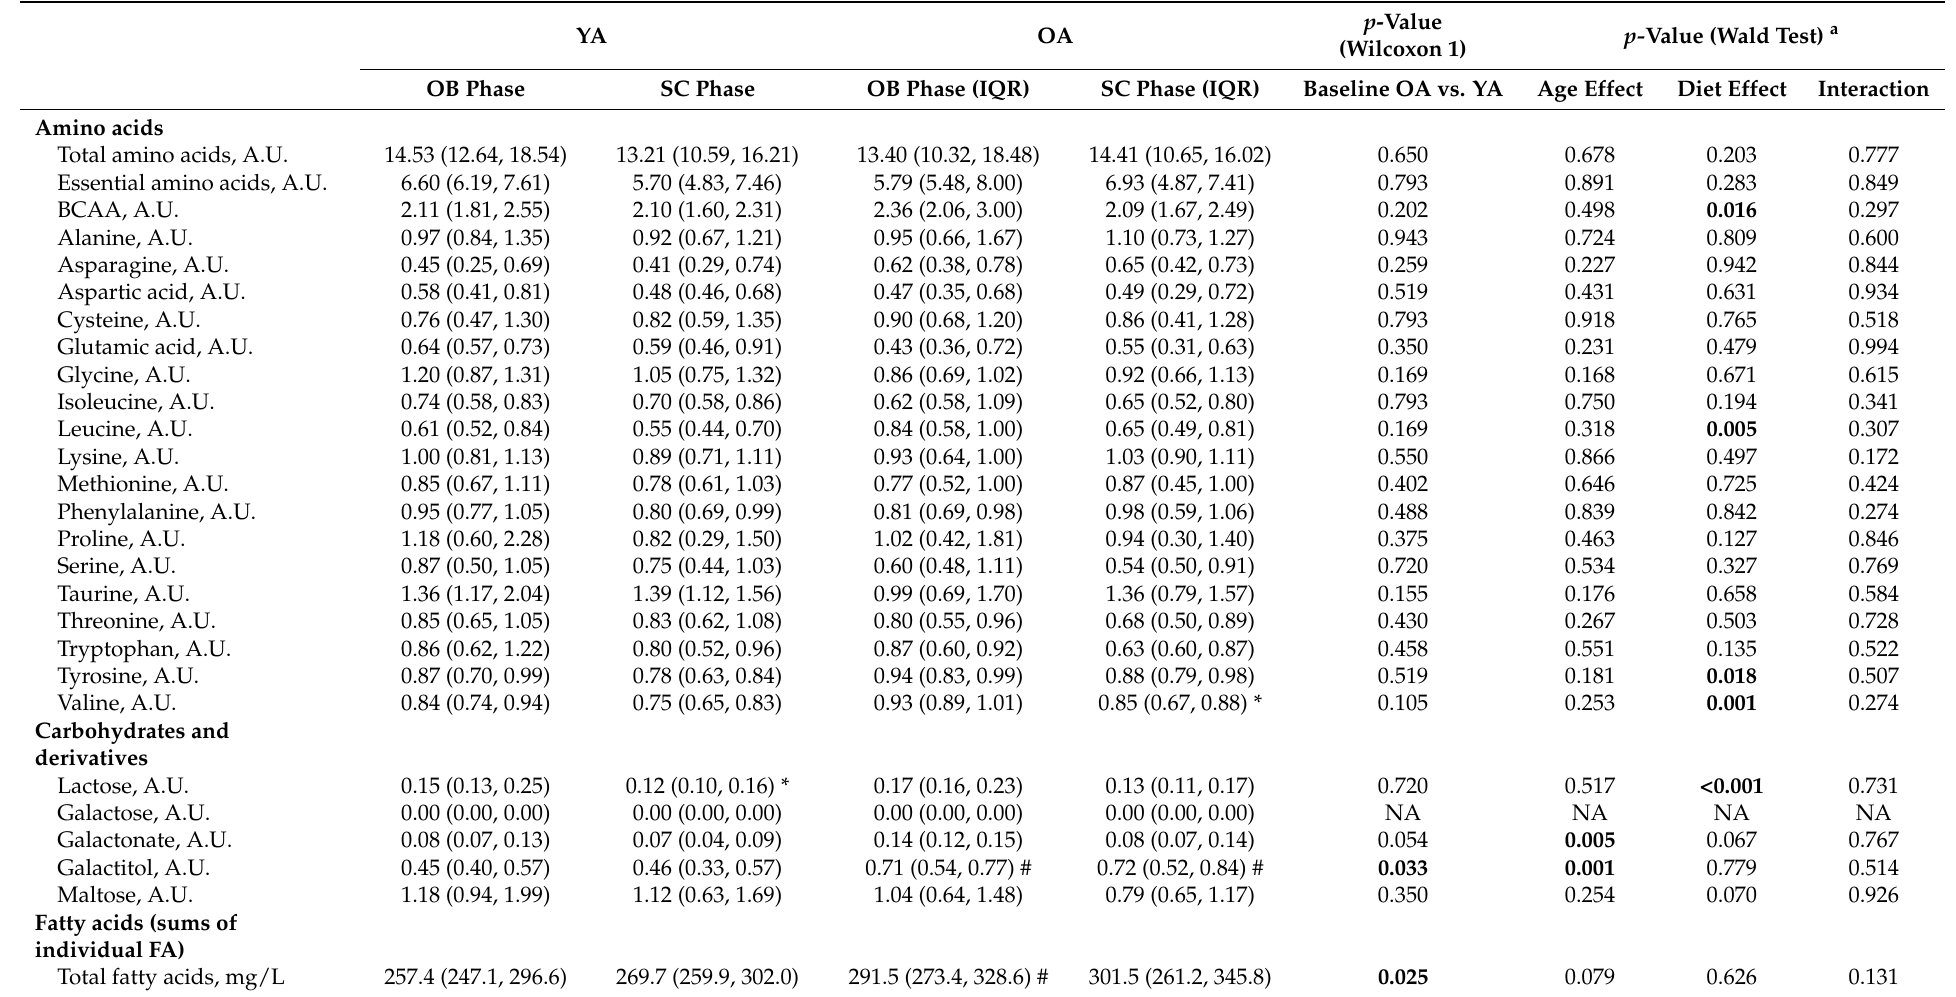
Table 4. Fasting serum levels (median (IQR)) of blood metabolites during observation and semi-controlled diet periods in young and older men.